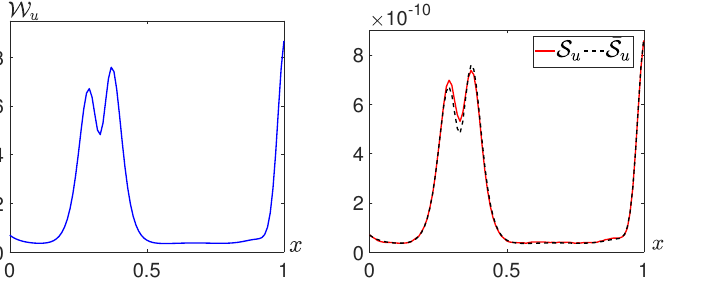
Figure 9. Stochastic Systems (1), (2) with a = d = e = 0.5, b = c = 1, D u = 5 × 10 − 4 , D v = 0.02, ε = 10 − 5 : stochastic sensitivity function W u of the 1.5 ↑ pattern ( left ); estimation ¯ S u of the mean- square deviation S u ( right ).